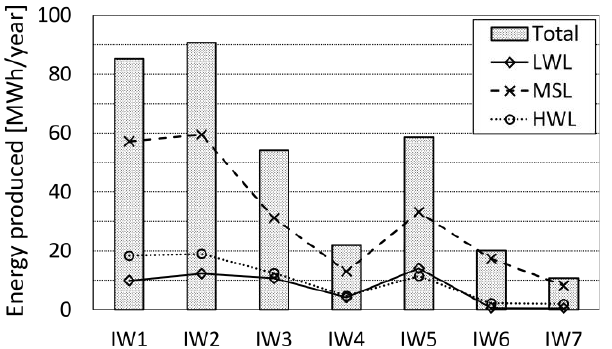
Fig. 14. Energy produced by the OTD component for each water depth tested and total.